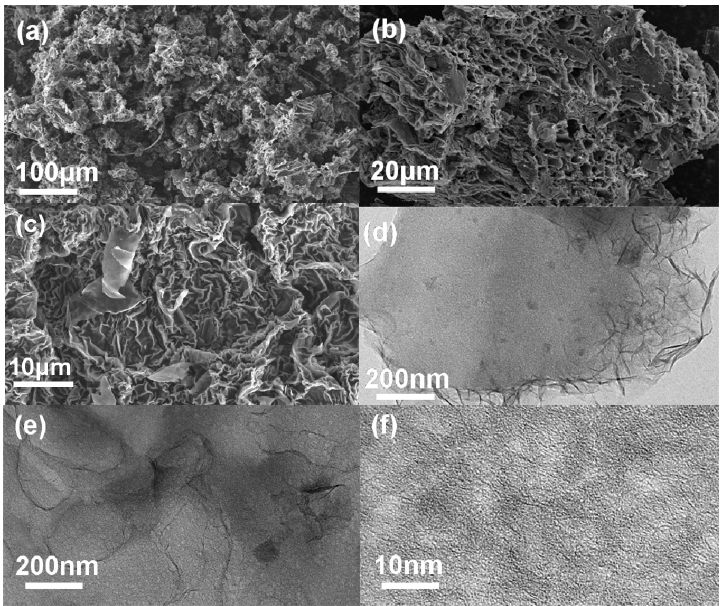
Figure 2. ( a – c ) SEM images of double activated water hyacinth-derived carbon (AAWHC). ( d – f ) TEM images of AAWHC.